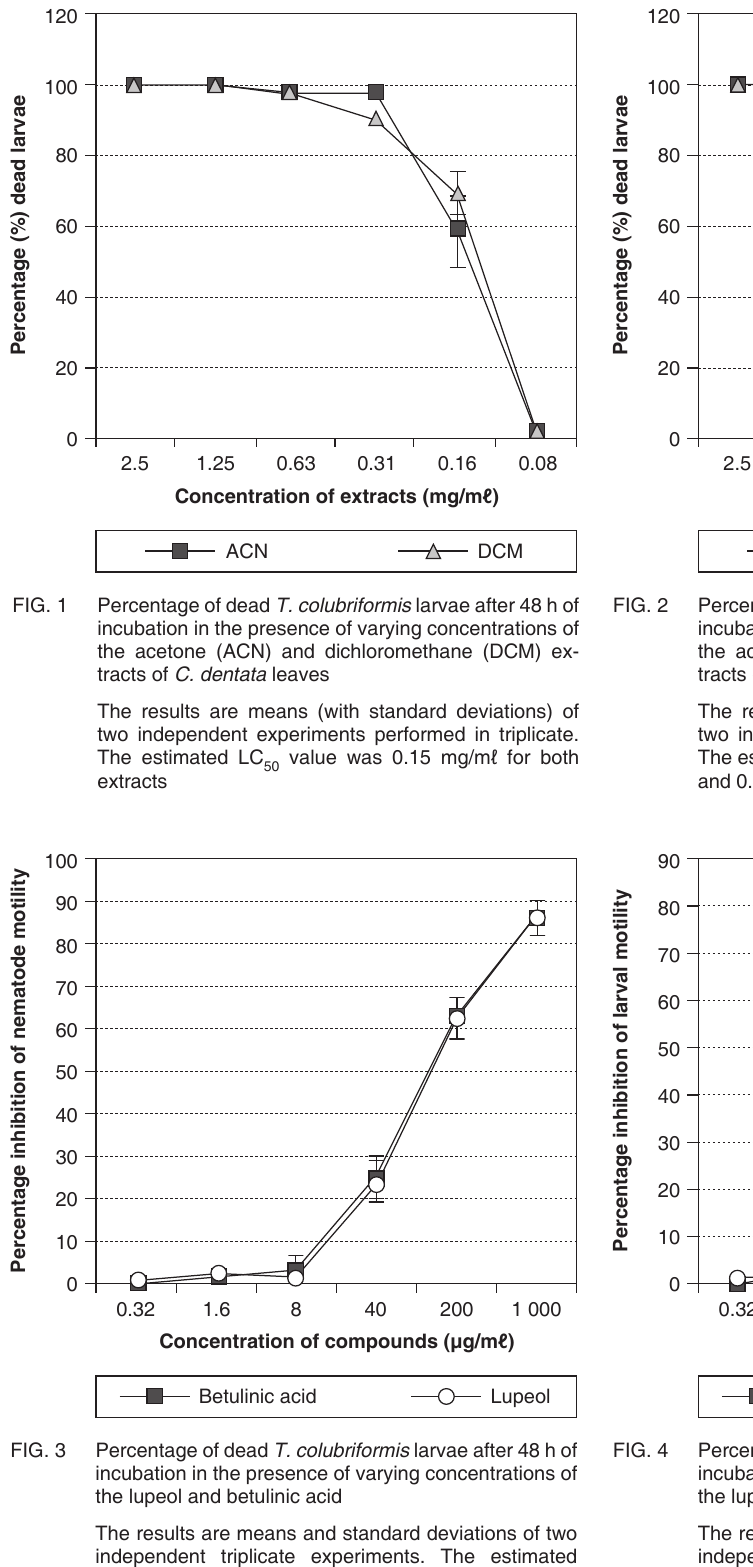
FIG. 4 Percentage of dead H. contortus larvae after 48 h of incubation in the presence of varying concentrations of the lupeol and betulinic acid The results are means and standard deviations of two independent triplicate experiments. The estimated LC values were 20 μ g/m ℓ for lupeol and 50 μ g/m ℓ for 50 betulinic acid